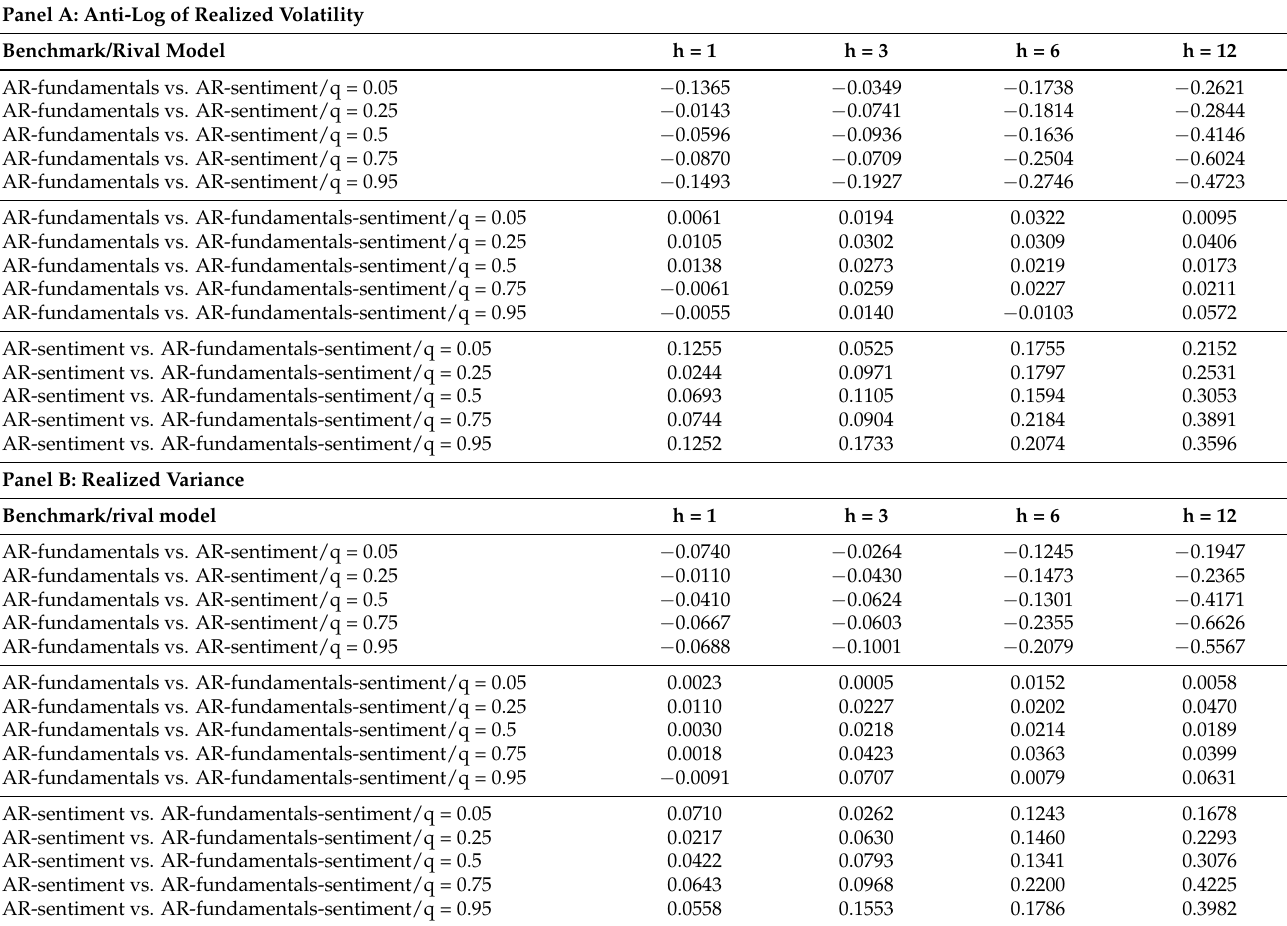
Table 4. Results for the anti-log of realized volatility and realized variance (WSJ